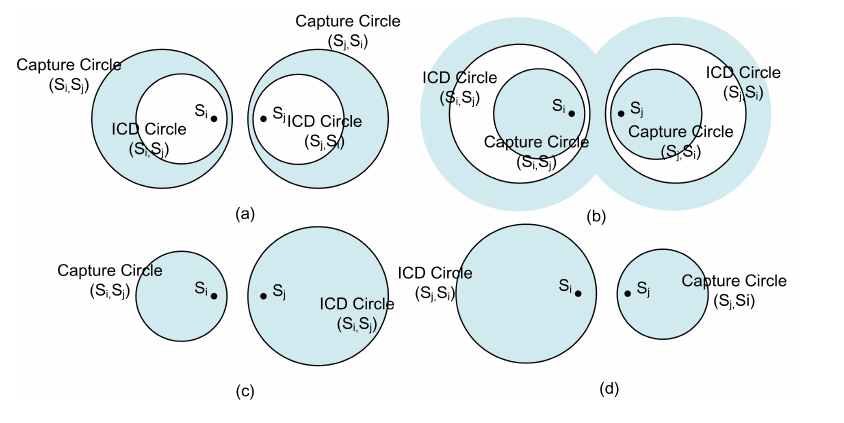
< z ≤ 1 ; ( b ) 1 ; τ τ 2 τ 2